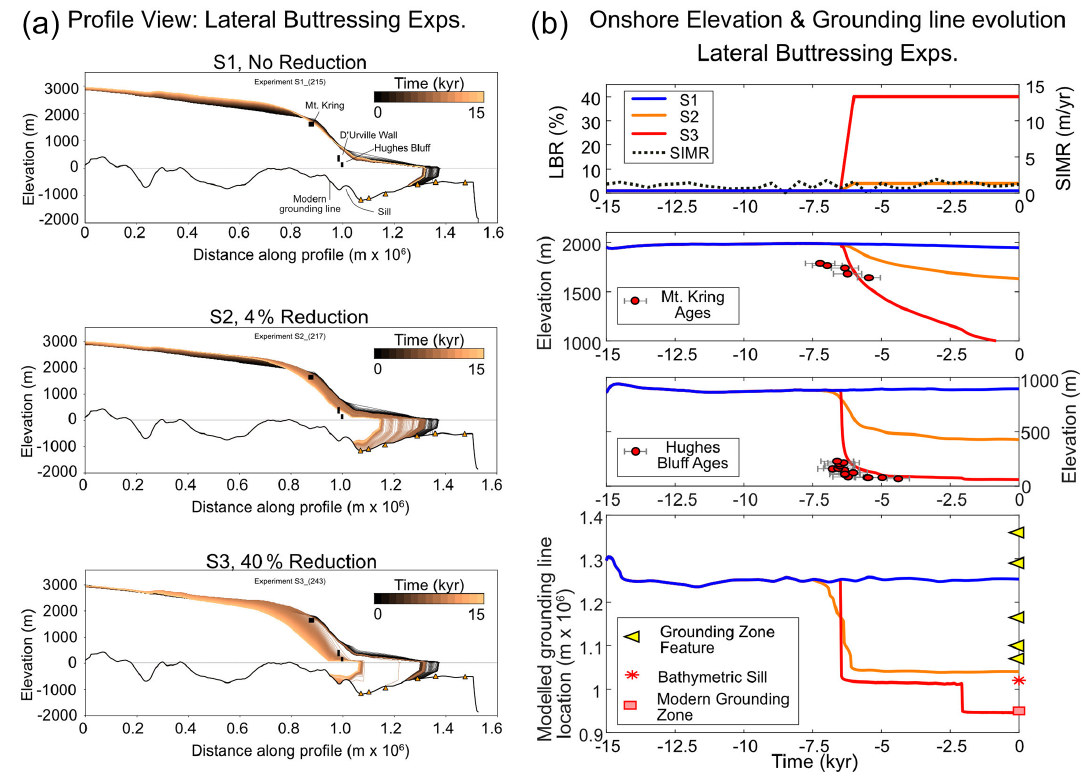
Figure 10. (a) Profile view: 15kyr evolution of modelled upper ice surface along flowline for lateral buttressing reduction (LBR) experiments. Black bars represent elevation range from three sites in this study. Orange triangles represent offshore features marking observed grounding zone wedges. (b) Onshore elevation and grounding-line evolution for LBR experiments. Top subpanel: forcings applied (no relationship be- tween LBR and SIMR). Top middle subpanel: time-transgressive elevation profile for Mt Kring with exposure ages; bottom middle subpanel: time-transgressive elevation profile for Hughes Bluff surface exposure ages; and lower subpanel: evolution of grounding-line position with modern grounding-line position, bathymetric sill at the mouth of David Fjord and mapped grounding zone features. We co-view exposure age data in these plots to allow generalised time-varying geometric relationships to be